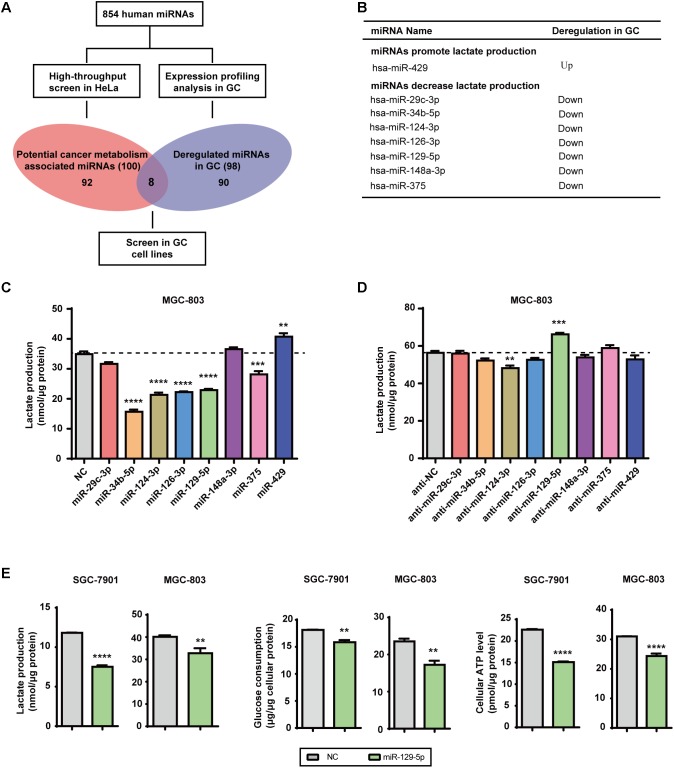
MicroRNA-129-5p is a repressor of glucose metabolism in GC cells. (A) A schematic diagram of the protocol used to search for candidate metabolism-associated miRNAs in GC. (B) Eight miRNAs were identified as candidate glycometabolism-regulating miRNAs in GC. (C,D) Lactate production in MGC-803 cells after transfection of the indicated miRNAs (C) and corresponding inhibitors (D). (E) Lactate production, glucose consumption and cellular ATP levels in GC cells transfected with miR-129-5p mimic. Values are shown as the mean ± standard error of the mean (SEM), n = 3 in (C–E). ∗∗P < 0.01; ∗∗∗P < 0.001; ∗∗∗∗P < 0.0001.